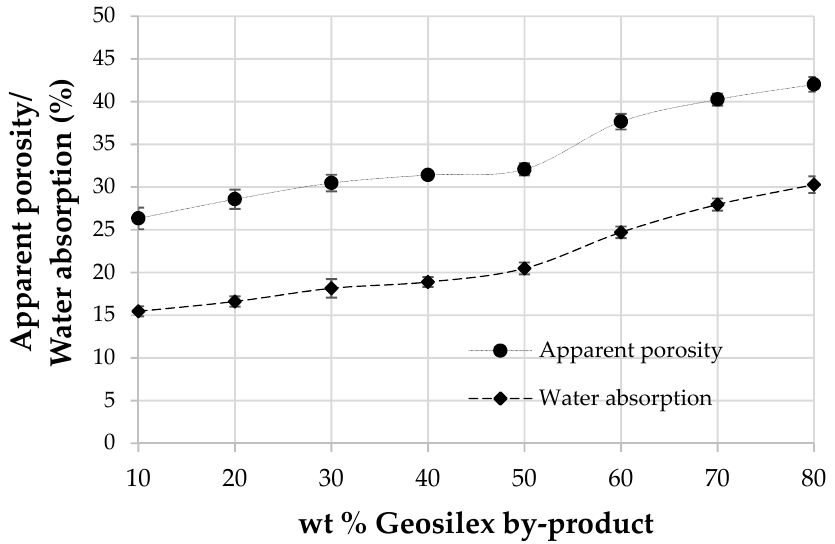
Figure 9. Apparent porosity and water absorption of the xWBA-yG calcium silicate units as function of G by-product content.